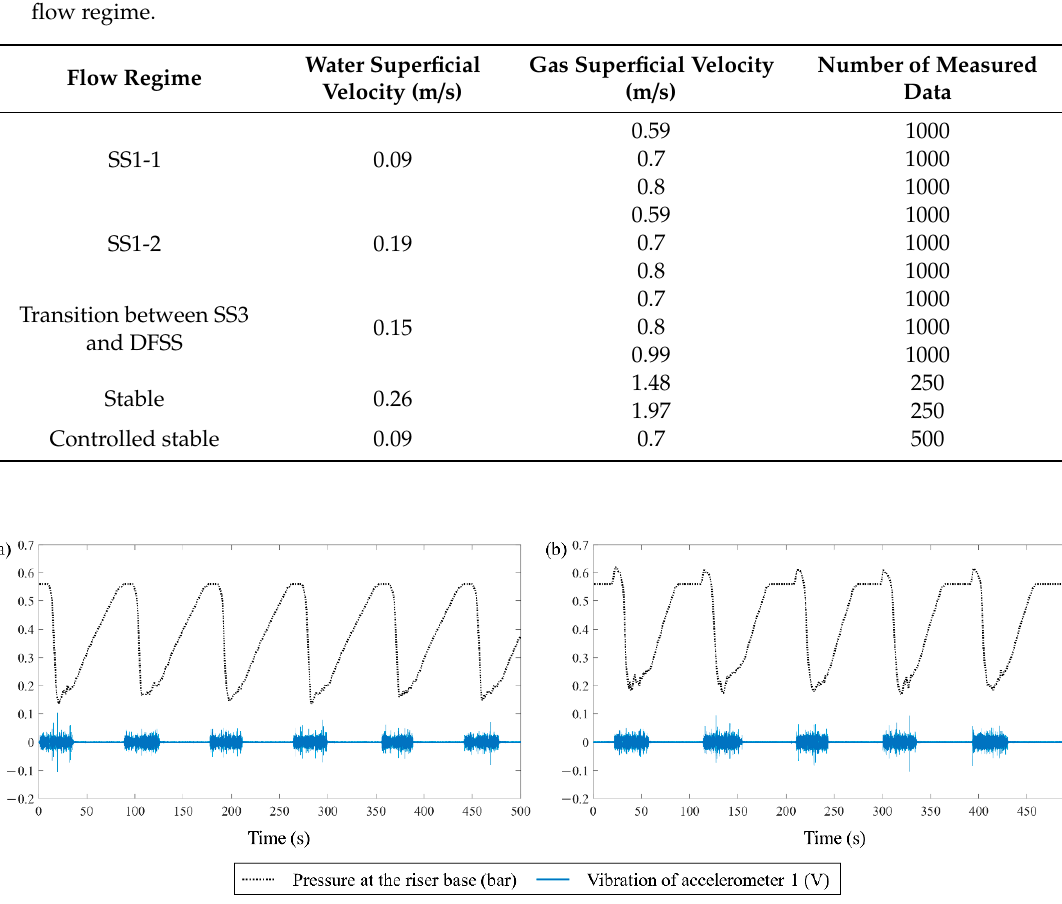
Table 1. Water and gas superficial velocities and the number of measured data according to the flow regime.